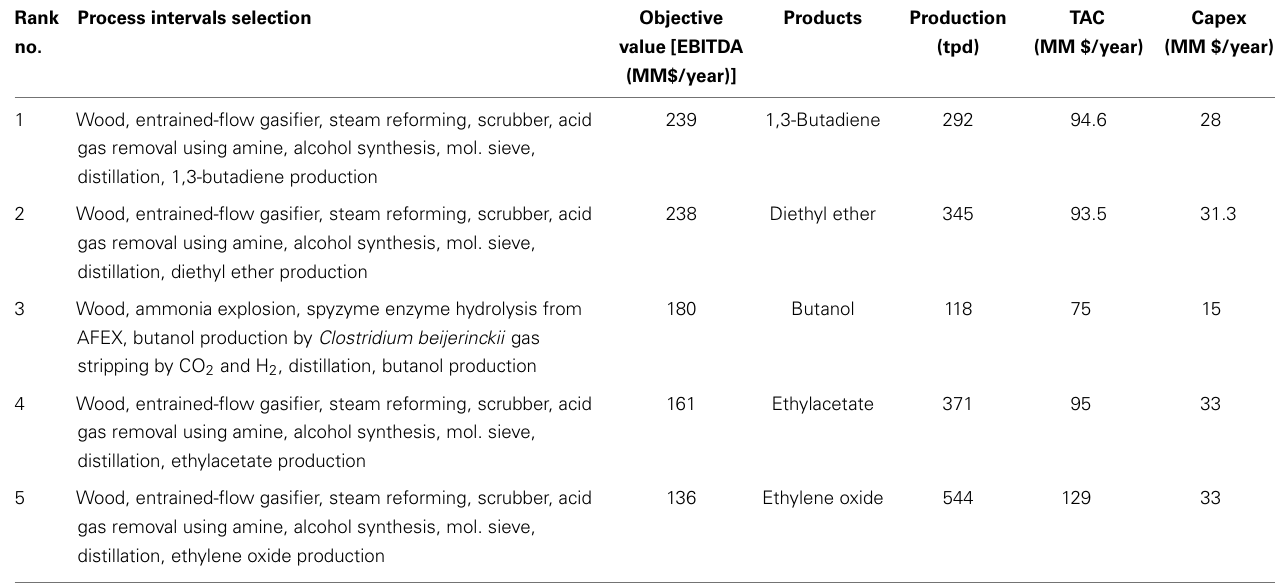
Table 11 |Top-five ranking of the optimal solutions using Model 4 ( + 30 to + 100%) for capital cost estimation (max. EBITDA of producing ethanol derivatives)